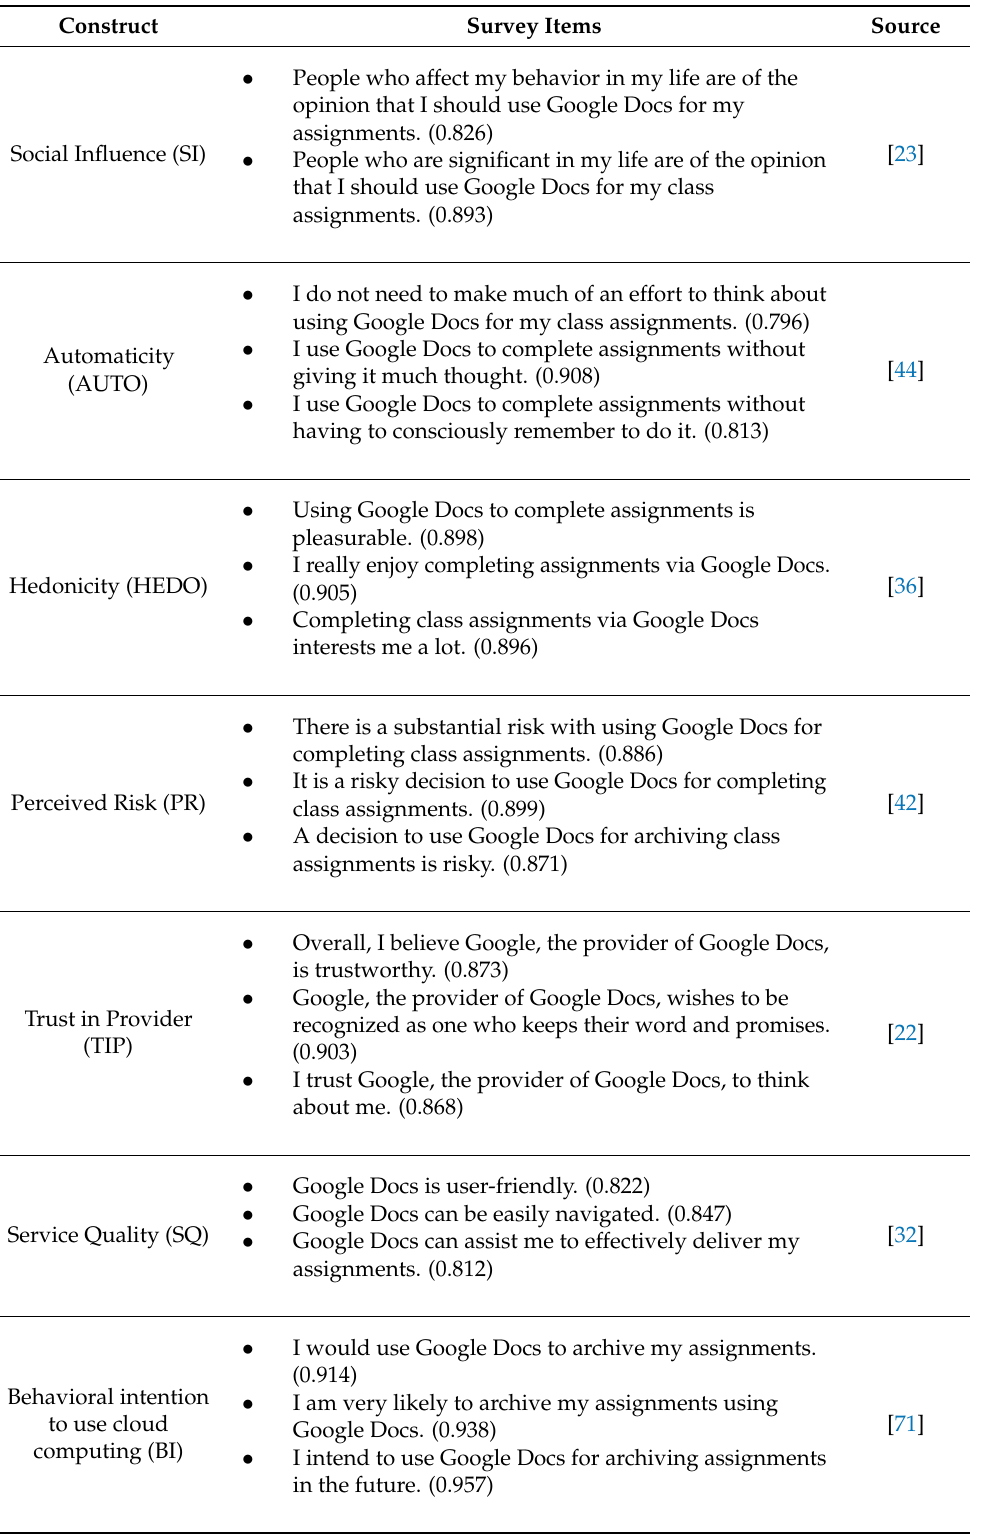
Table 1. Construct of